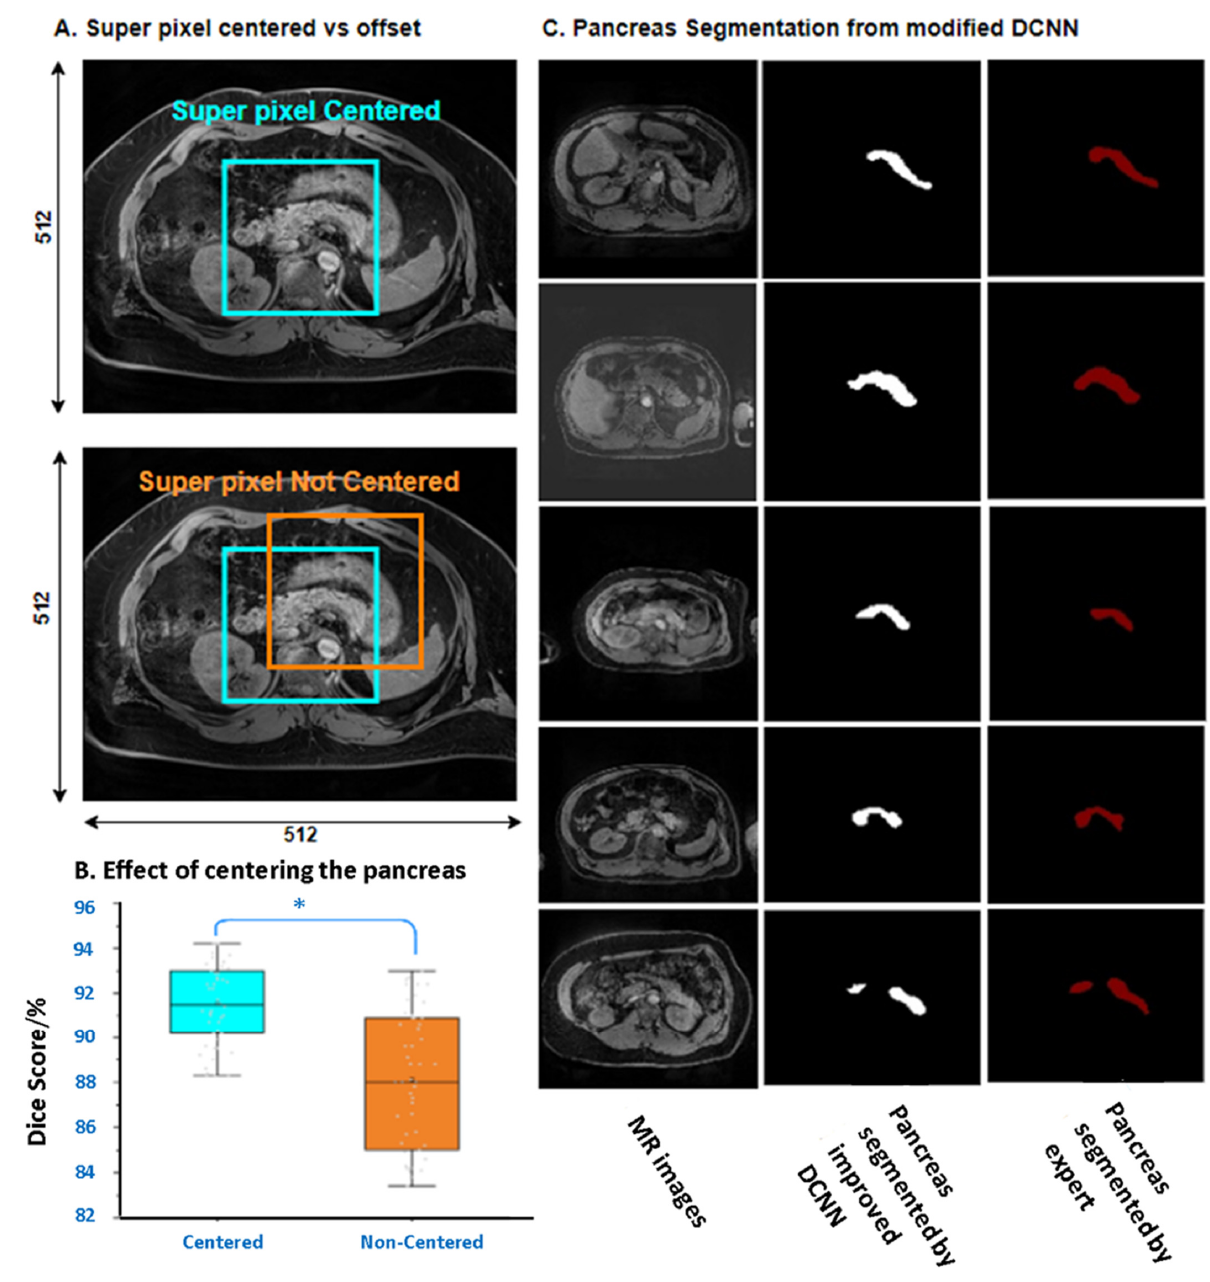
Figure 7. ( A ) Effect of superpixel centering of modified DCNN. ( B ) Performance summary comparing the superpixel segmentation methods of pancreas images, centered and non-centered. ( C ) The pancreatic segmentation results of DCNN and expert manual operations. p < 0.05 *.